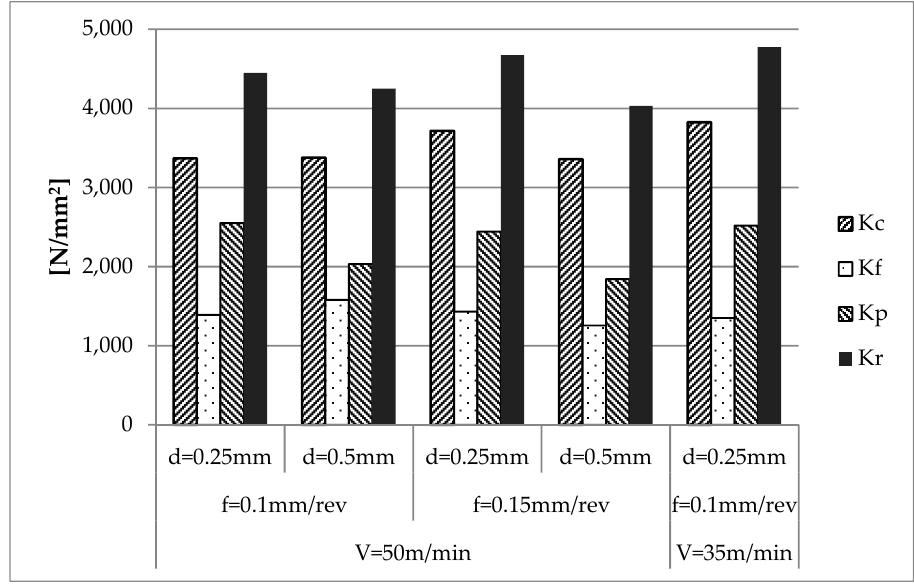
Figure 3. Initial specific cutting force components and specific resultant force in turning tests with carbide tool.